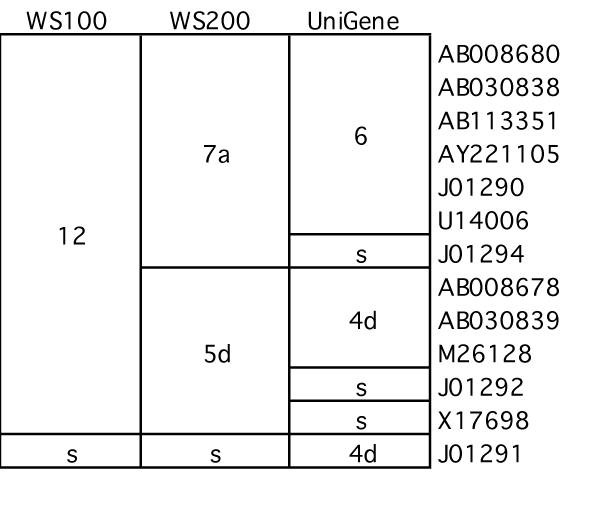
Cluster 12. Distribution of the 13 mRNA sequences of which 12 are WS100 Cluster 12. See Figure 1 legend for explanation of cluster designations. The right column corresponds to sequence accession numbers.